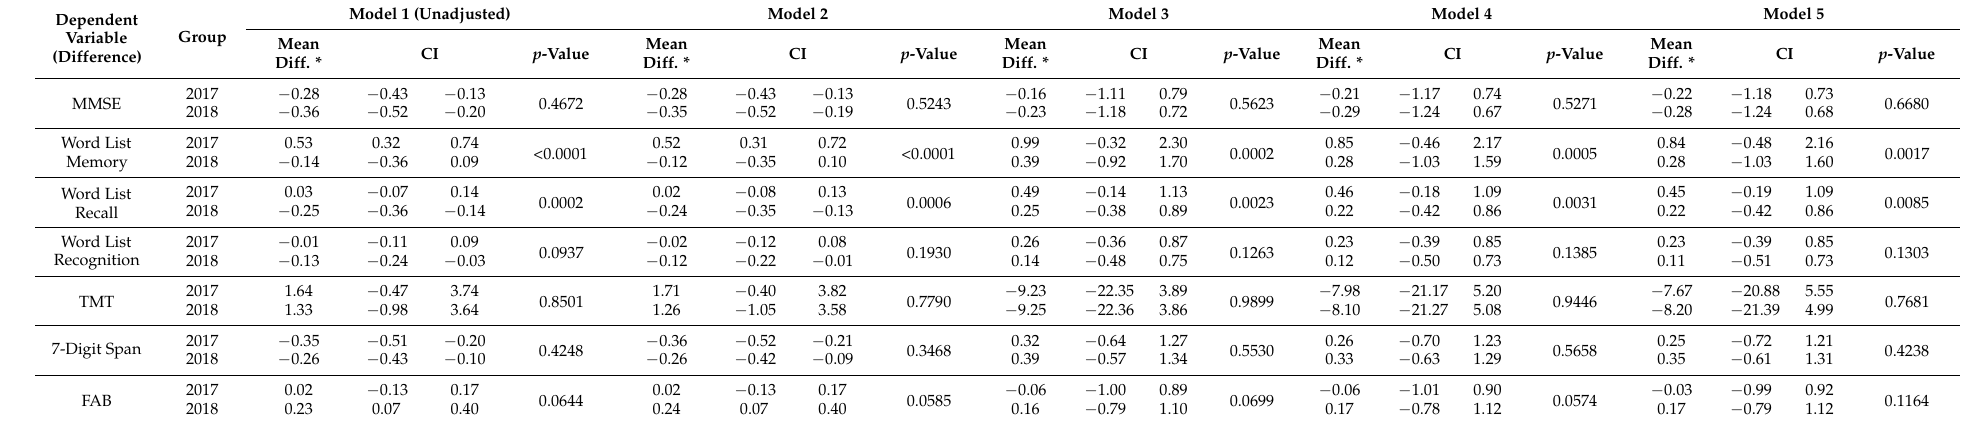
Table 3. Estimated mean differences of cognitive function during 2 years in 2017-Group and 2018-Group (intergroup comparison). Dependent